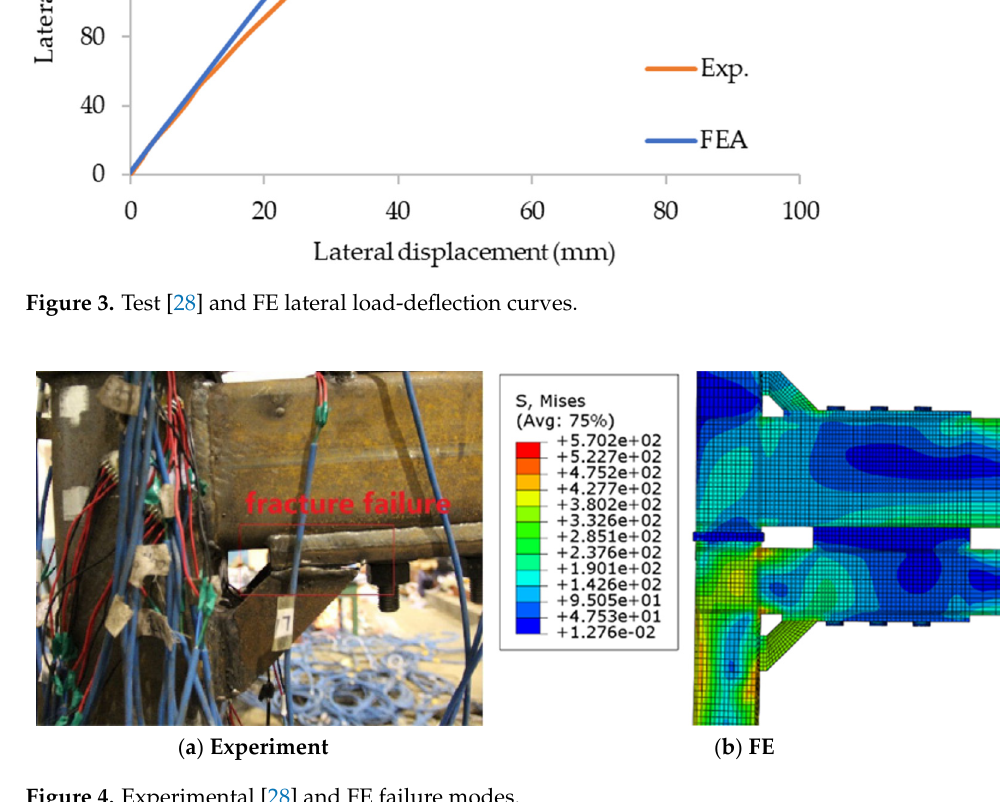
Figure 4. Experimental [28] and FE failure